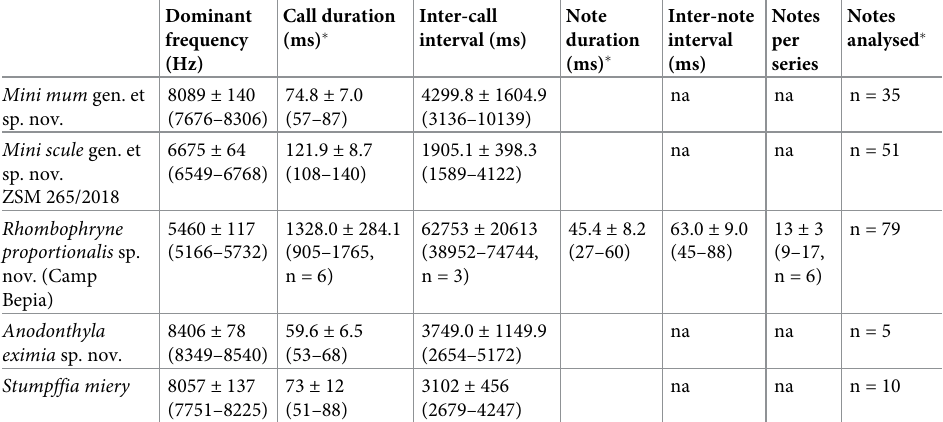
Table 2. Bioacoustic parameters of new species of miniaturised cophyline microhylids. Data on S . miery from Rakotoarison et al. [14], provided for comparison with the sympatric A . eximia . Values are presented as mean ± standard deviation, with range in brackets. na = not applicable. � In all species except R . proportionalis calls con- sist of a single note according to the definition herein, and in these species call duration is therefore synonymous with note duration. Dominant Call duration Inter-call interval frequency (ms) � (Hz)